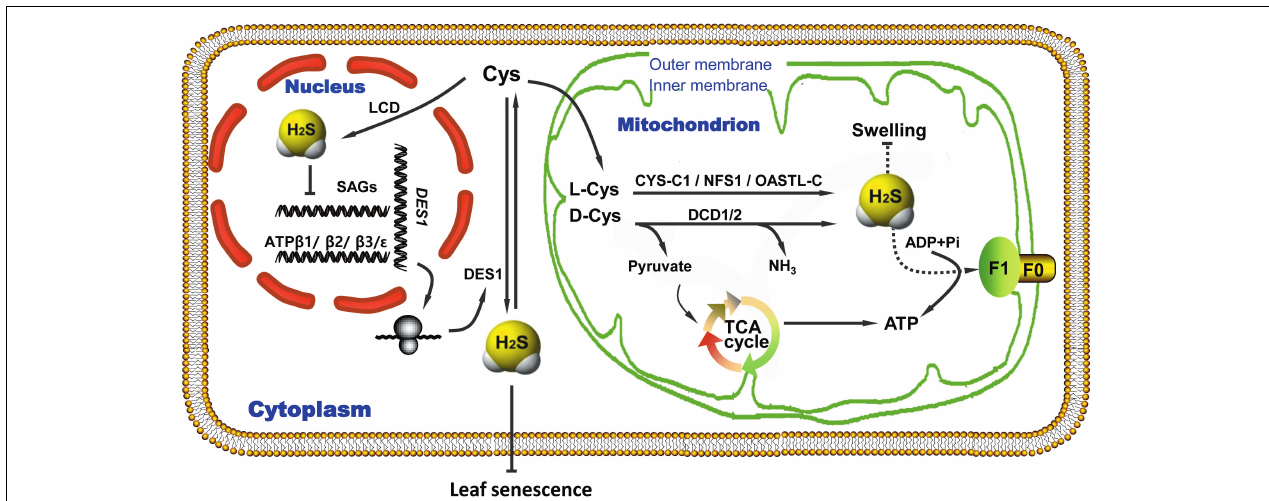
FIGURE 6 | Proposed regulatory model of ATP production induced by endogenous H 2 S to delay leaf senescence under drought-stress conditions. ADP, adenosine diphosphate; ATP, adenosine tiphosphate; Cys, cysteine; CYS, cyanoalanine synthase; DES1, cysteine desulfhydrase; F 0 /F 1 , complex of ATP synthase; H 2 S, hydrogen sulfide; LCD/DCD, L / D -cysteine desulfhydrase; NFS1, cysteine desulfurase; OASTL, O -acetyl- L -serine(thiol)lyase; SAGs, senescence-associated genes; TCA, tricarboxylic acid; Arrow end, activation; Blunt end,